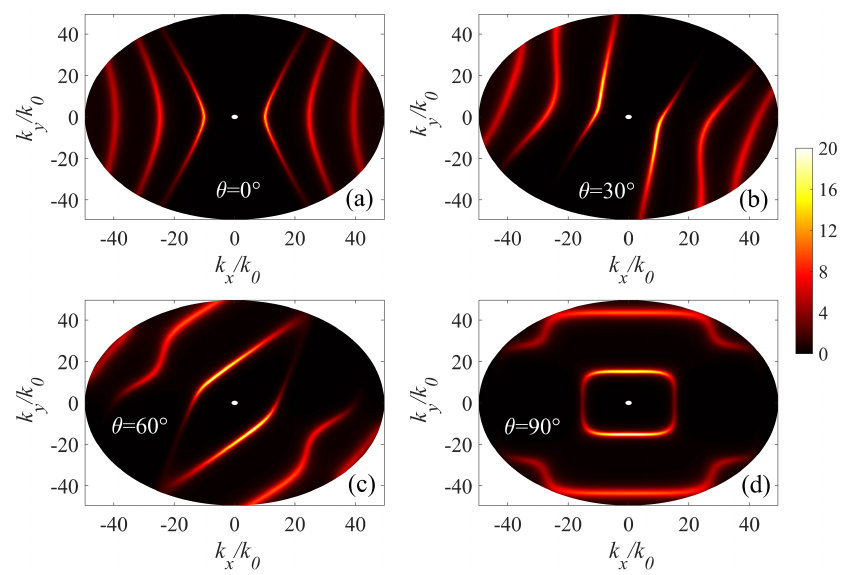
Figure 4. Contours of the imaginary part of the reflection coefficient ( Im ( r pp ) ) in the wave vector space at a frequency of 900 cm − 1 under different twist angles without any external magnetic